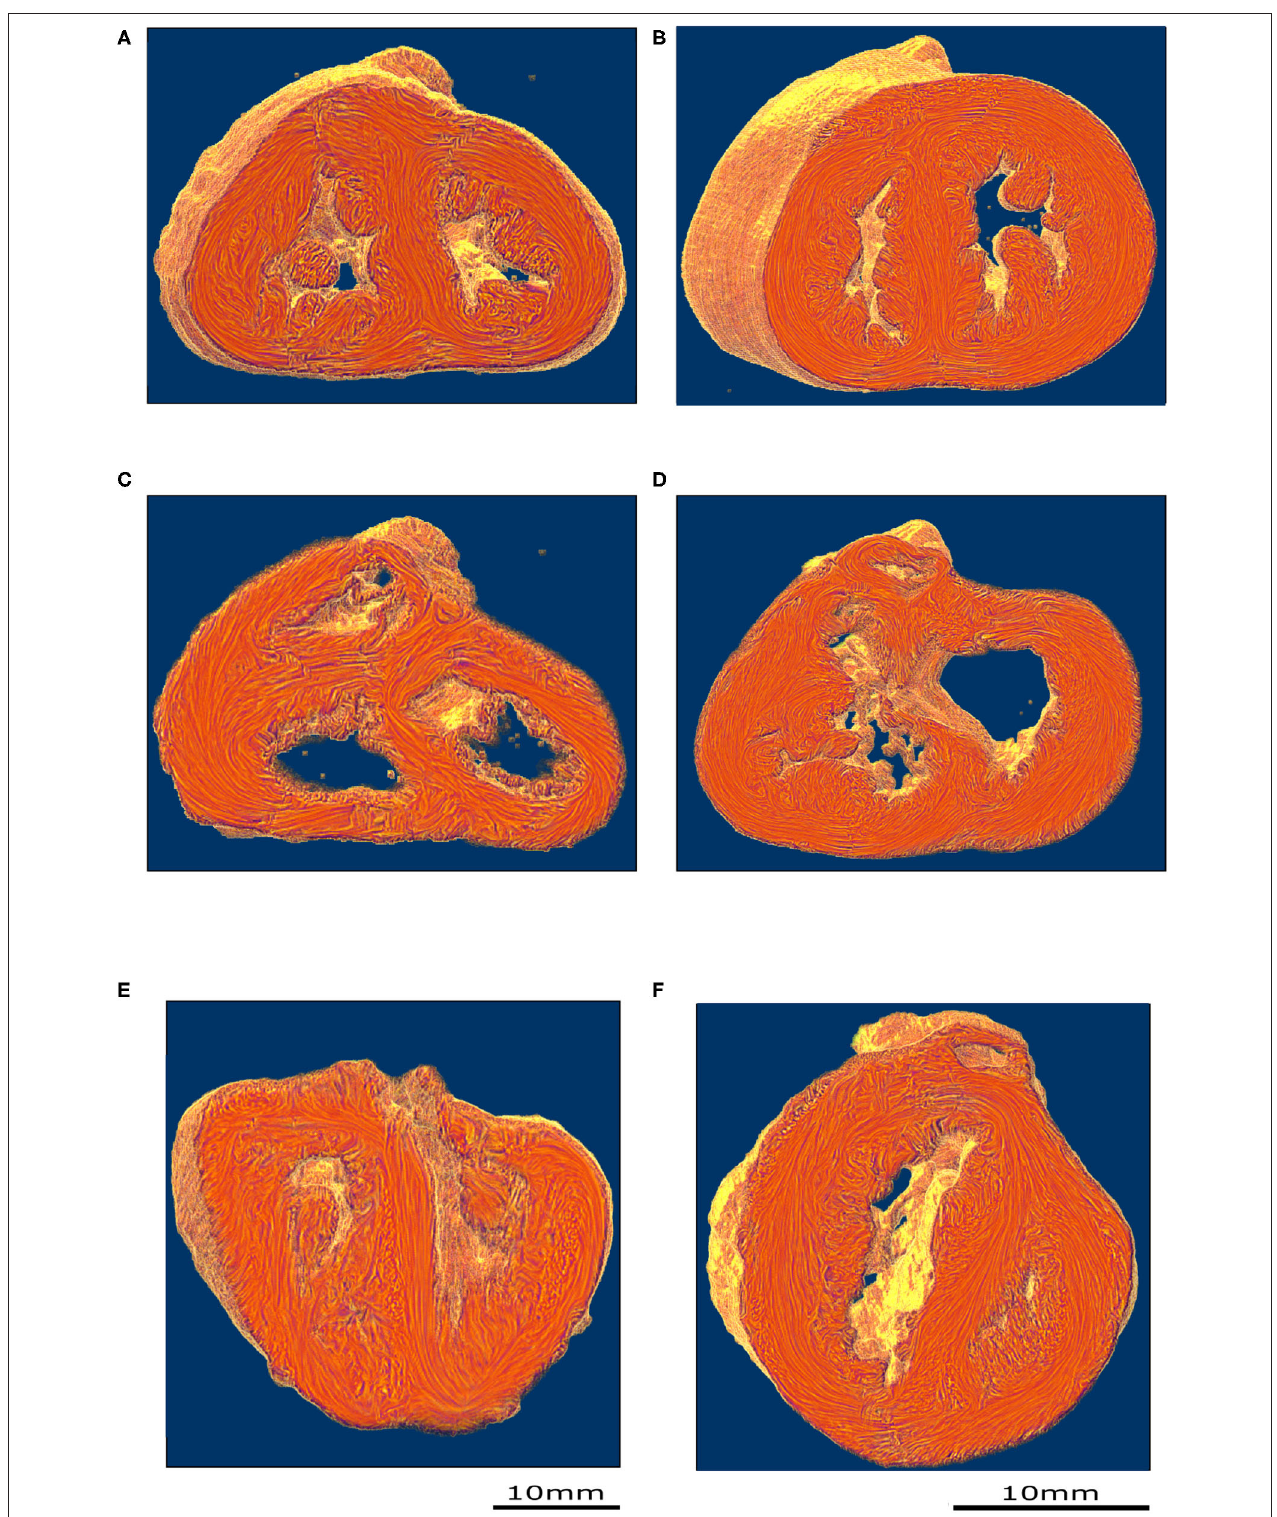
FIGURE 3 | Virtual dissection of the ventricular mass LIC maps: left column-control, right column-ToF. Upper row, equatorial level (A,B) ; middle row, basal level (C,D) ; lower row (E,F) oblique sections. From the equatorial level to the apex (A,B) , no marked difference in the 3D architecture of the myocardial cells was found between the two groups. At the basal level, in the control hearts, the deep muscular continuity of the VIF and the IVS is verified (C) . In short axis section, the deep alignment